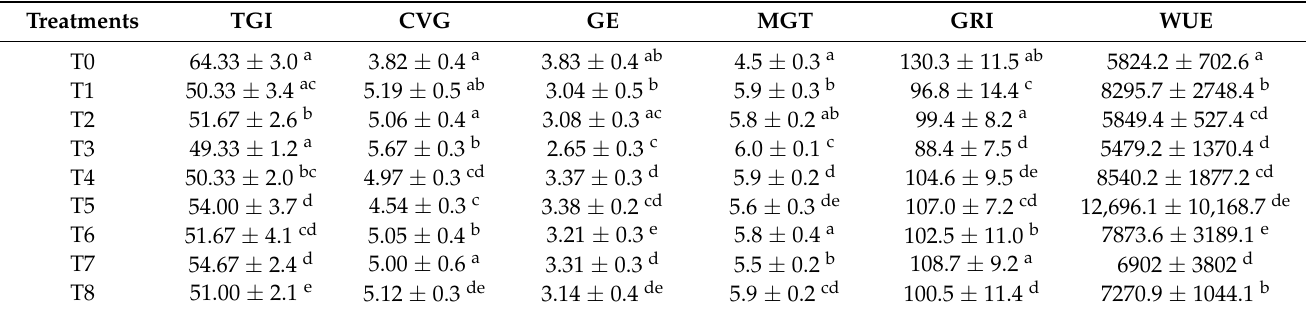
Table 2. Effect of AsA and/or α -toc on A. sativa TGI, MGT, CVG, GE, MGT, GRI, and WUE under water-deficit